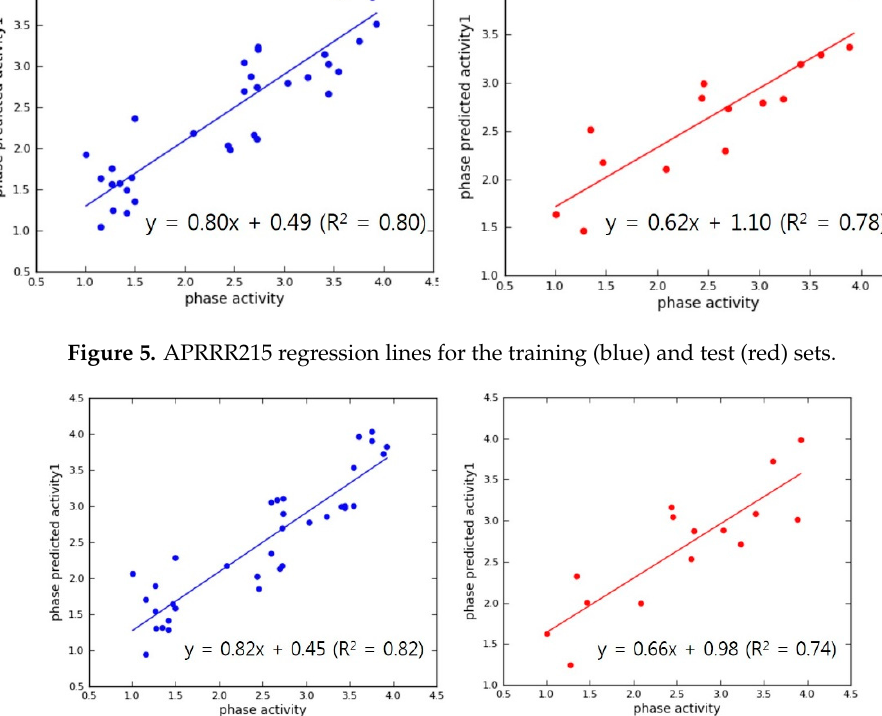
Figure 6. AHPRRR104 regression lines for the training (blue) and test (red) sets.